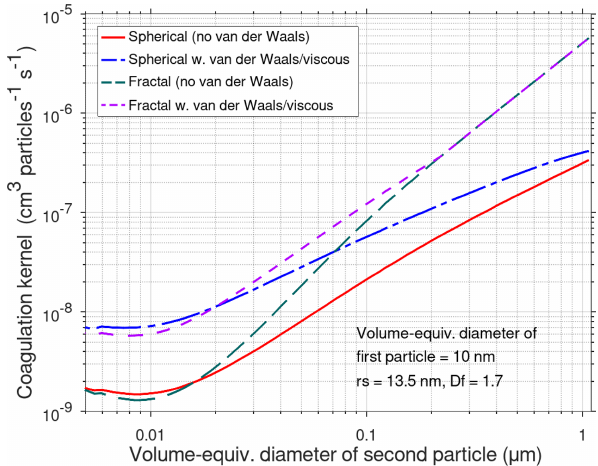
Figure 3. Modelled effect of fractal geometry and van der Waals– viscous forces when the volume-equivalent diameter is 10nm and the volume-equivalent diameter of the second particle varies from 5 to